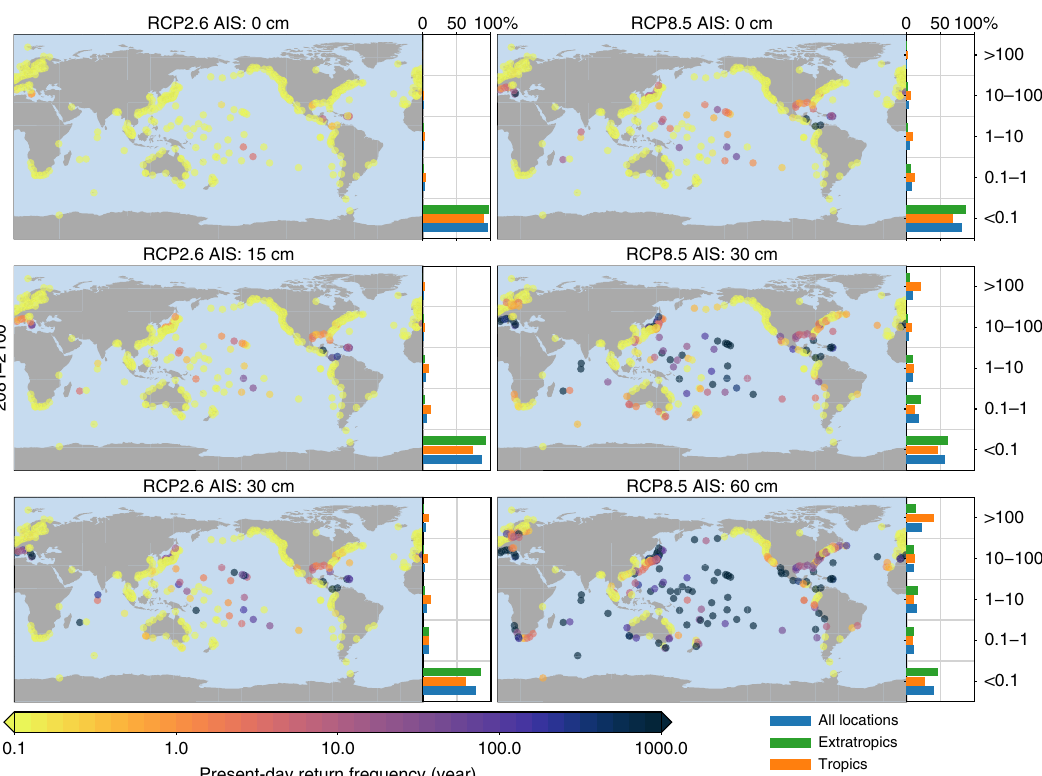
Fig. 7 Projected mean sea-level changes versus present day extreme sea-level events. Each panel shows the present-day return period that that has a return height equal to the expected mean sea level above present-day mean sea level in 2081 – 2100 for each scenario. A value of 10 years means that the expected MSL change is the same as the present-day return height with a return period of 10 years. The bars on the right of each plot show a histogram of the tropical, extratropical, and all